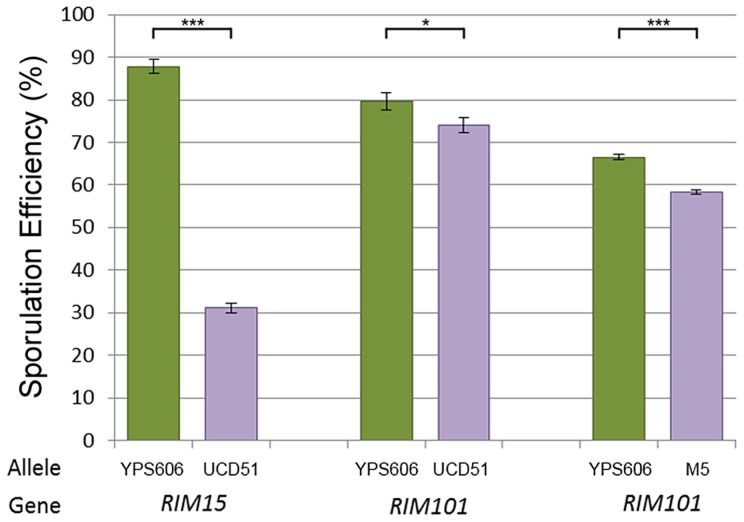
Reciprocal hemizygosity analysis.Bar color and allele label correspond to the allele present in the hemizygous strain; green – vineyard allele knockout, oak allele remaining, purple – oak allele knockout, vineyard allele remaining. Error bars show standard deviation among at least 4 independent knockouts (t-test, *** indicates P<0.001, * indicates P<0.01).